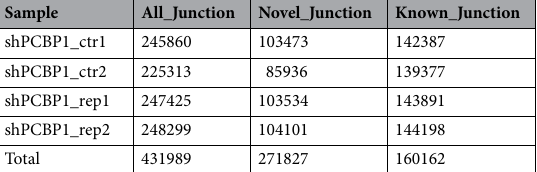
Table 2. Splicing junction analysis of samples from RNA-seq data. RNA-seq RNA sequencing, PCBP1 poly C binding protein 1.